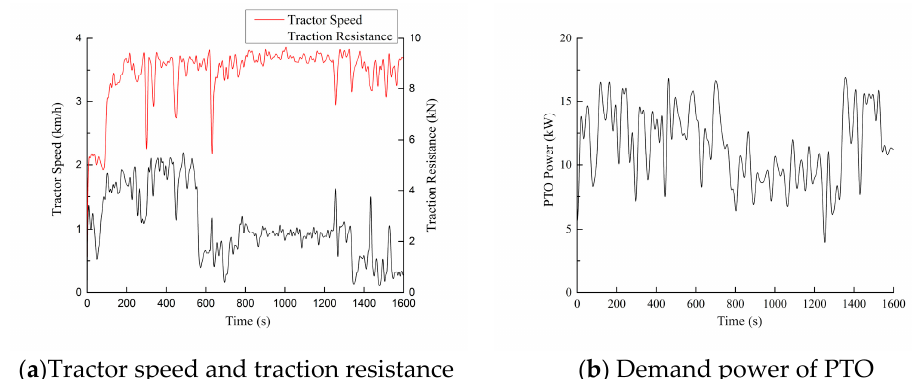
Figure 15. Rotary tillage cycle for an agricultural tractor.